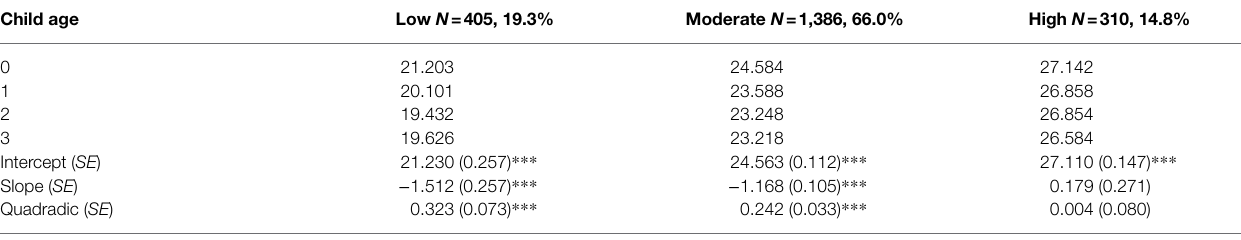
TABLE 3 | Sample means of maternal responsive parenting from child age 0 to 3 by trajectories ( n = 2,101). Child age Low N = 405, 19.3%